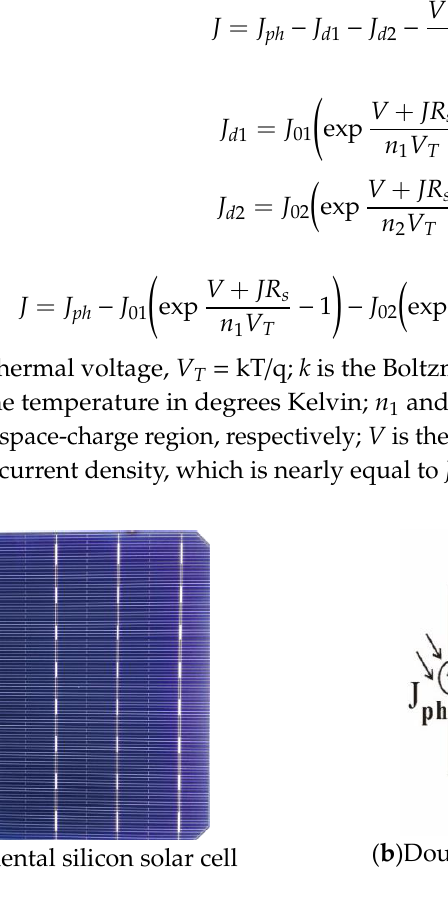
Figure 2. The experimental silicon solar cell and the double-diode model.